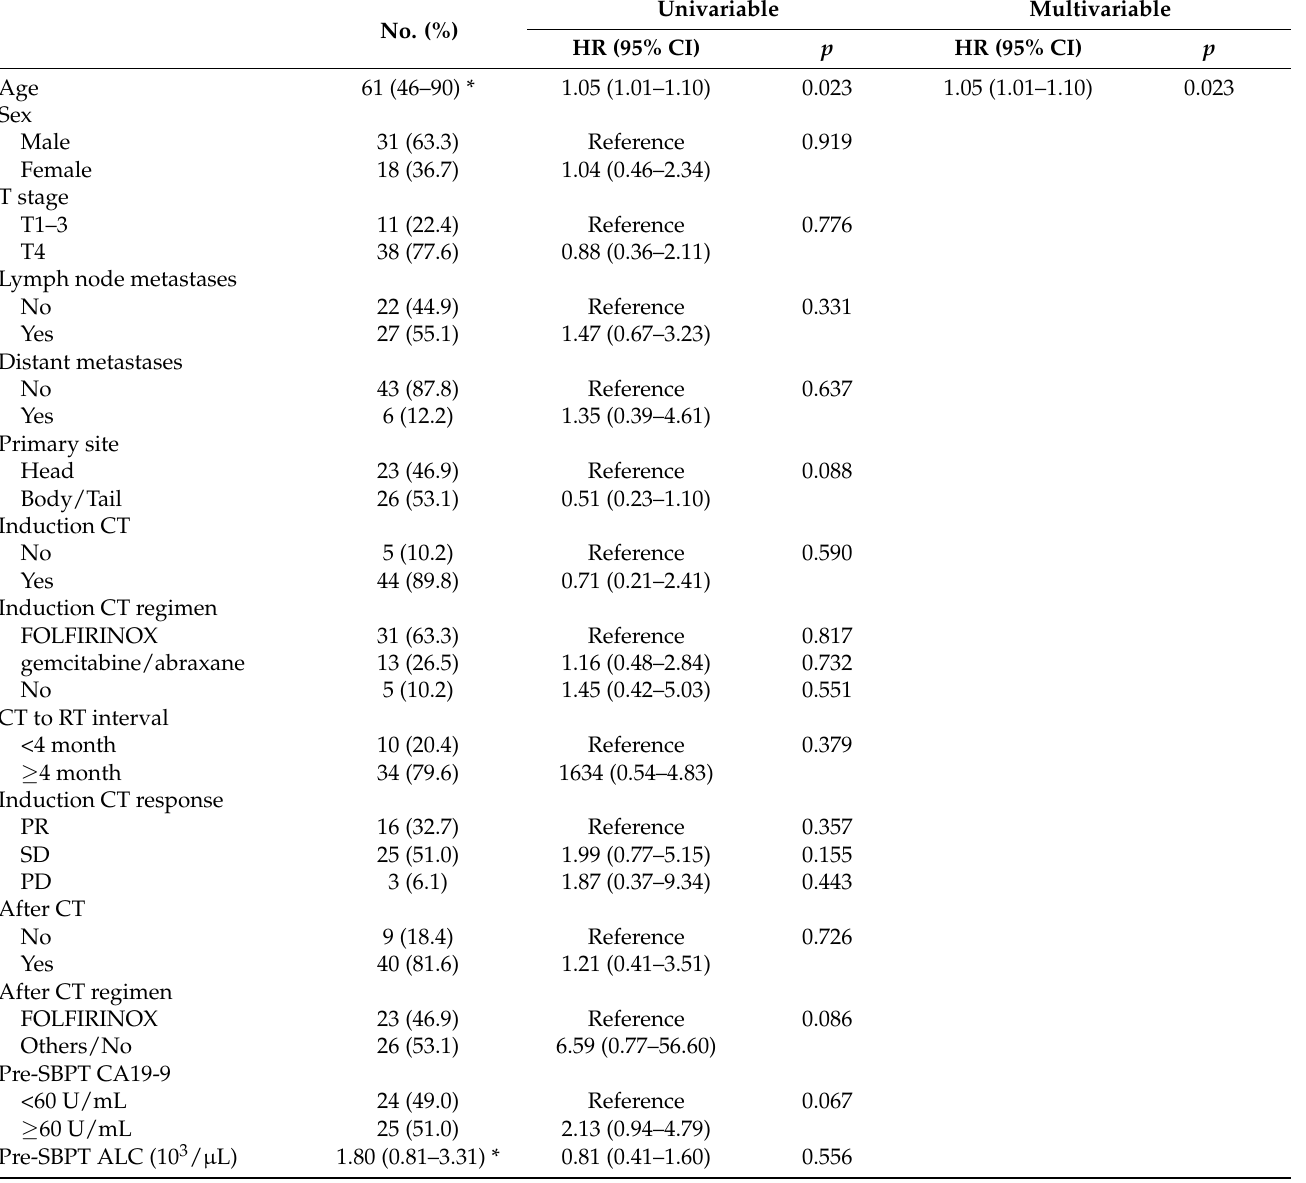
Table 4. Univariate and multivariate Cox proportional hazard models for local control ( n =